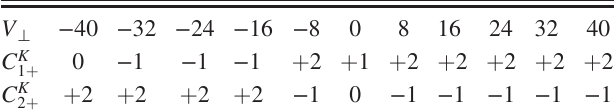
TABLE II. The dependence of the Chern numbers on vertical electric potential for ( 2 þ 1 )-layer TMG.